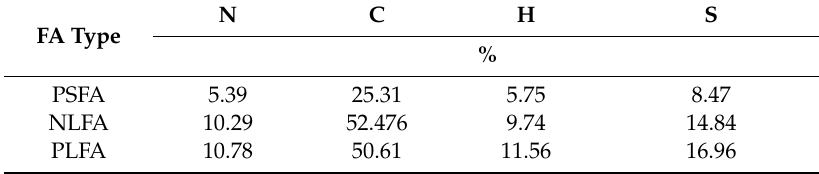
Table 5. Elemental composition of plant- and mineral-derived fulvic